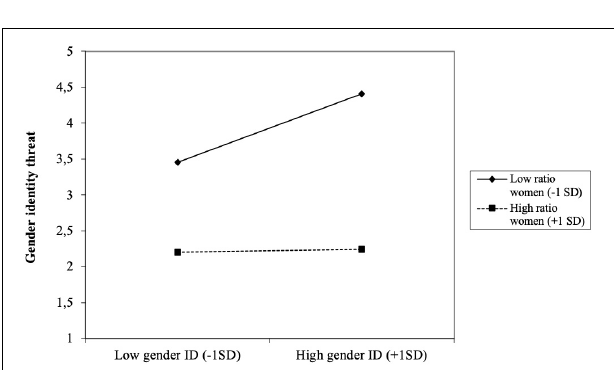
FIGURE 4 | Two-way interaction-effect work sector (STEM vs. non-STEM) × gender identification on gender identity threat among women.